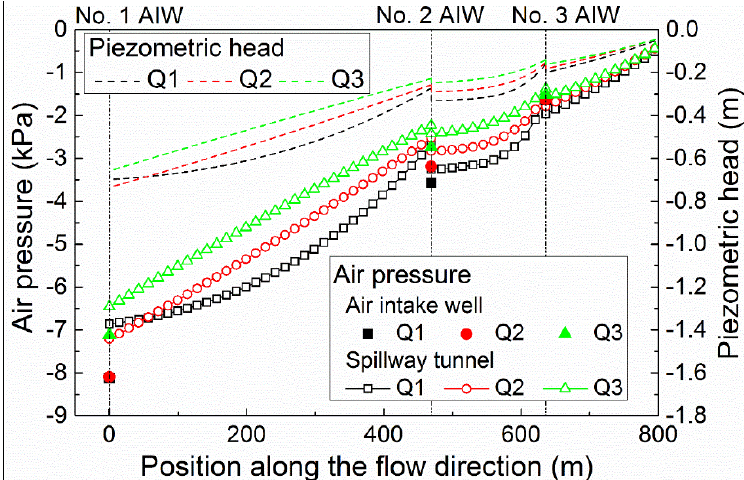
Figure 8. Comparison of the pressure in the spillway tunnel and the air intake well.